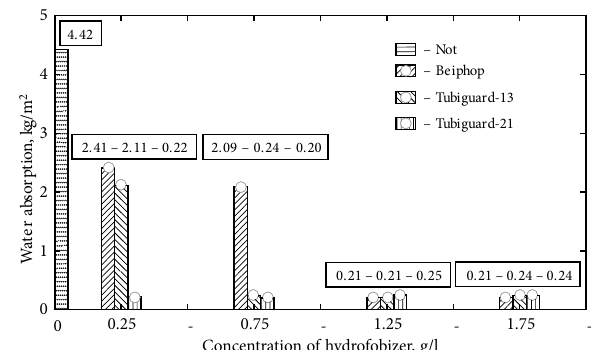
Fig. 5. Influence of hydrophobic additives on hemp fibre composite short-term water